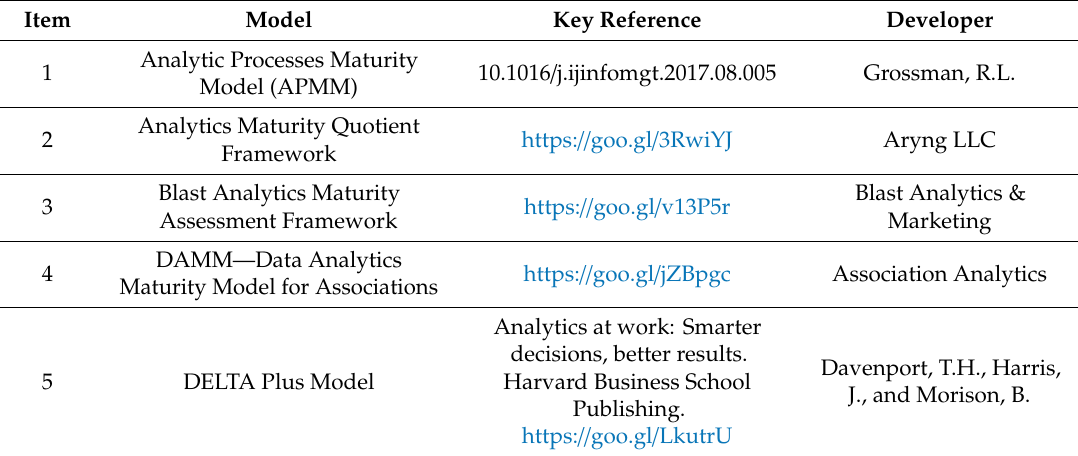
Table 1. Analytics maturity